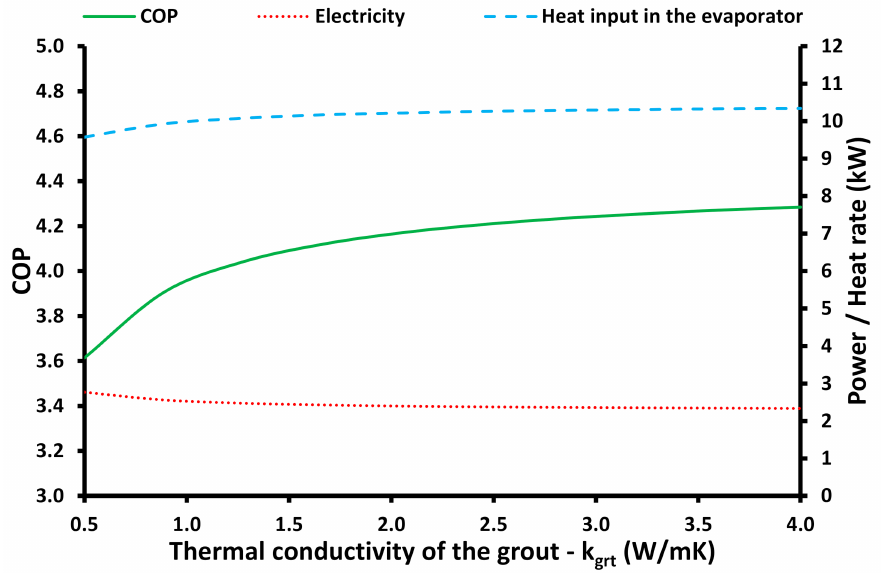
Figure 16. The impact of the grout thermal conductivity on the COP, electricity consumption and heat input in the evaporator.